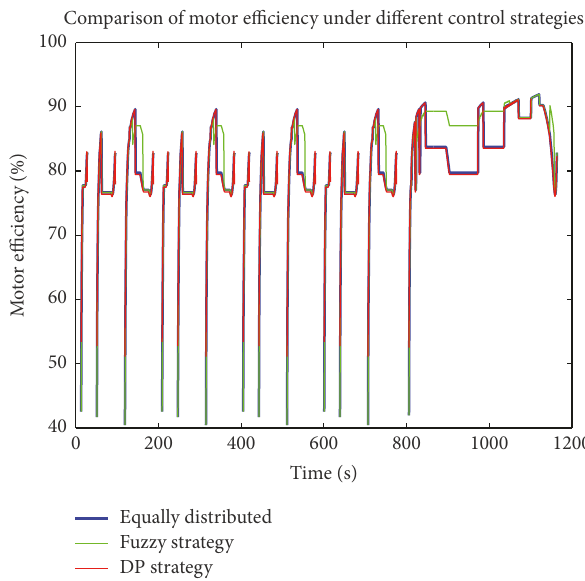
Figure19:Motorefficiencycomparisondiagramofdifferentcontrol strategies under NEDC road condition.